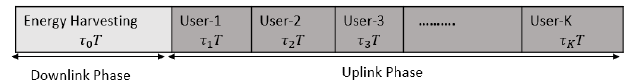
Figure 3. The frame-based WPCN scheme: The total frame is divided into two phases. In the downlink phase, the H-AP transmits an energy signal to all users. The second phase, the uplink phase, shows the allocation of time for each user to send an information signal to the